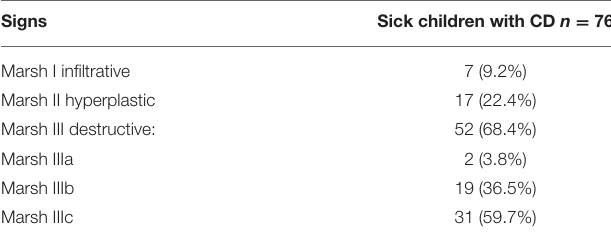
TABLE 2 | Histological findings according to Marsh classification in patients with celiac disease ( n = 76). Signs Sick children with CD n = 76